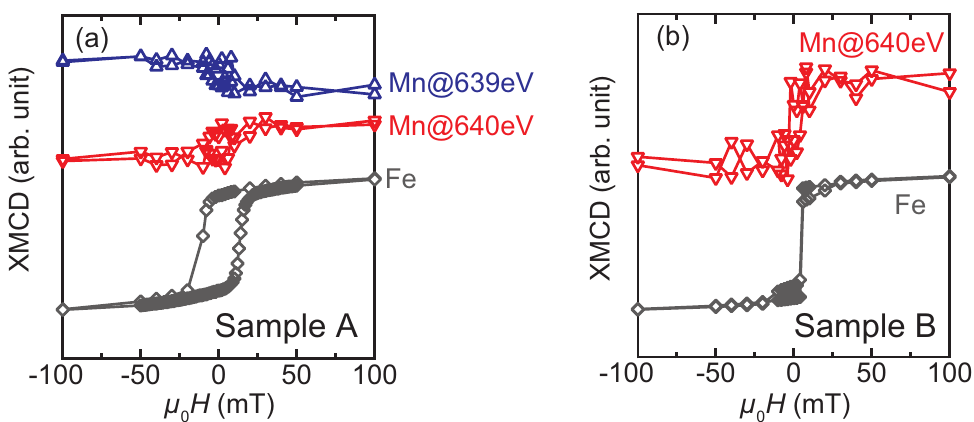
Figure 7. Element-specific MCD hysteresis loops, ESMHs, around the L 3 -absorption edges of Mn and Fe for ( a ) Sample A, which is the Mn 2 VAl/Fe layered film showing exchange bias, and ( b ) Sample B, which is the other layered sample showing no exchange bias. The XMCD signals of Mn were arbitrarily scaled for visual comparison.